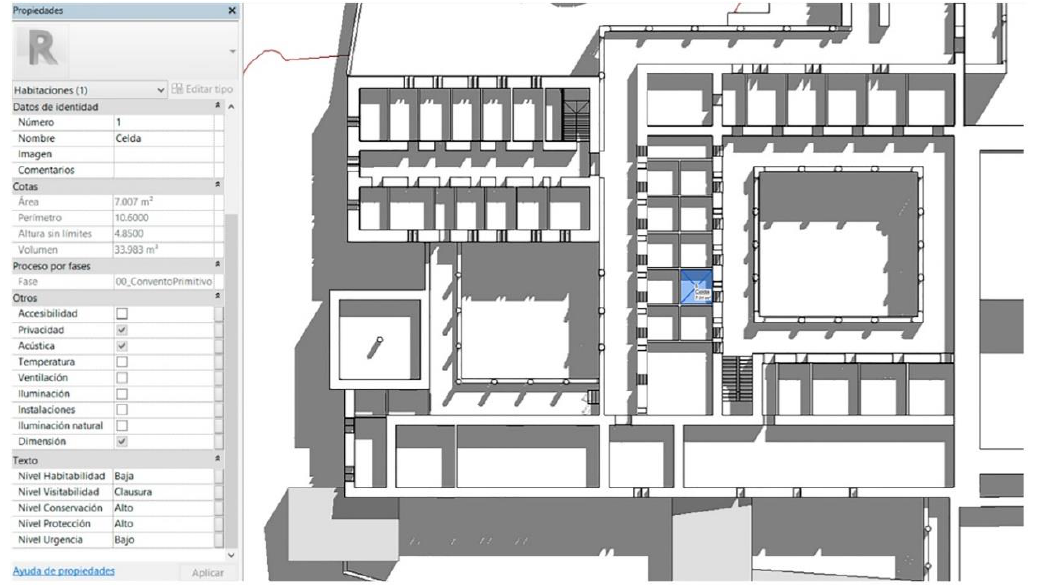
Figure 11. Study of the habitable spaces of the monastic complex, 2021.